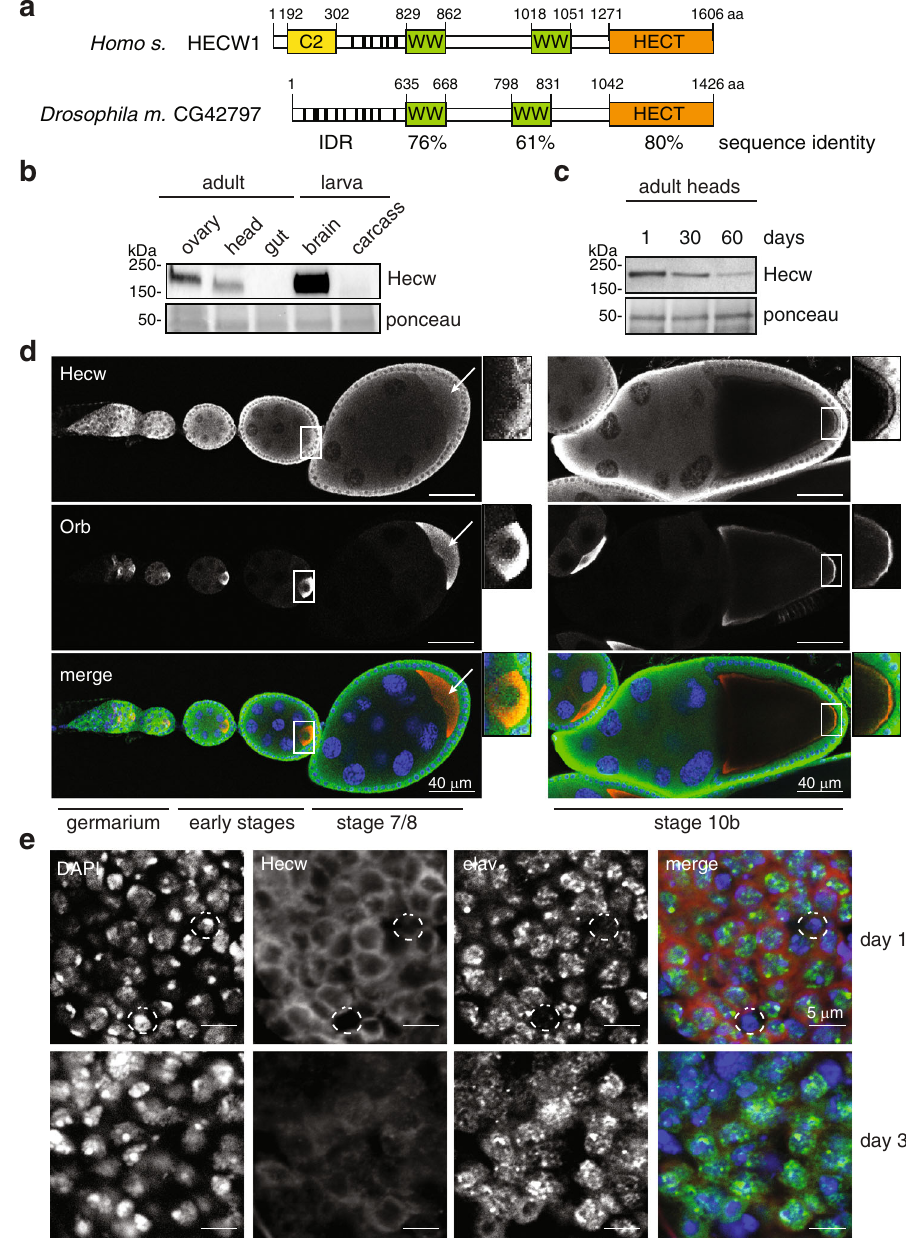
Fig. 1 Hecw is preferentially expressed in fl y gonads and central nervous system. a Schematic representation of human HECW1 and Drosophila CG42797 proteins. Domains shown are: C2 (Ca 2 + dependent lipid binding) domain in yellow, WW (substrate interacting) domains in green, and HECT (catalytic) domain in orange. The fl y ortholog shows no C2 domain and presents an extended intrinsically disordered region (IDR), identi fi ed by IUPred (https:// iupred2a.elte.hu/). Percentage of identity is reported below the domains. b Immunoblot (IB) analysis of the indicated Drosophila tissues performed with the anti-Hecw antibody. Ponceau shows equal loading. ( n = 3). c IB of fl y heads at 1, 30 and 60 days with the indicated antibodies. ( n = 3). d Immuno fl uorescence (IF) analysis of ovarioles of 3-day-old fl ies performed with the indicated antibodies. Left panels: germarium and previtellogenic stages 1 – 7. Right panels: stage 10 egg chamber. Hecw colocalising with Orb (oocyte marker) at the posterior margin of the fl y oocyte is indicated by white arrows and highlighted in the magni fi cations. Scale bar: 40 µ m. ( n = 3). e IF analysis of adult brains of 1-day-(upper panels) or 30-day-old fl ies (bottom panels) with the indicated antibodies. Neurons are marked with the anti-elav antibody and non-neuronal cells are circled in white. Scale bar: 5 µ m. ( n =